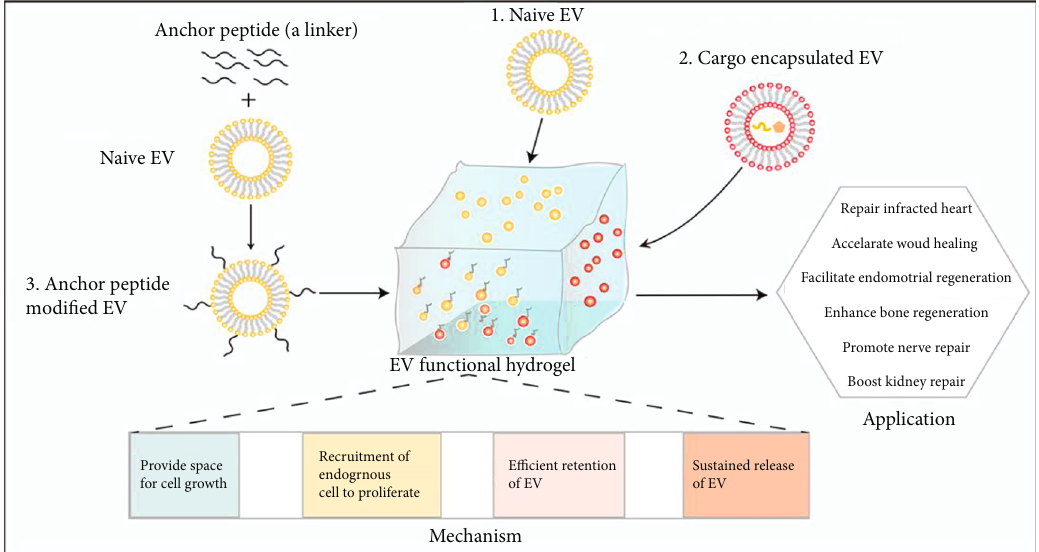
Figure 4: The role of EV functioned hydrogel. Naive EVs and cargos encapsulated EVs can be combined with hydrogels. In addition, in order to increase the retention e ffi ciency of EVs in hydrogel, anchor peptide can serve as a linker to bridge EV with hydrogel. EV functioned hydrogel is capable of promoting infarcted heart repair, accelerating wound healing, boosting kidney repair, strengthening nerve reparative outcome, and enhancing bone and endometrial regeneration.